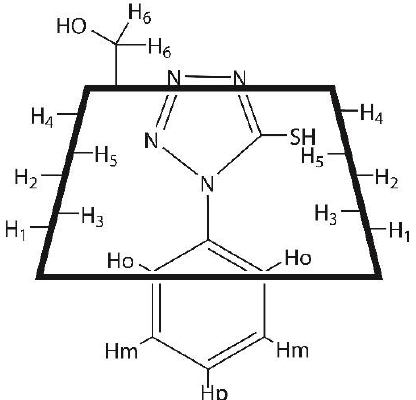
Figure 3. Proposed geometry for the inclusion of MPT into β-CD as deduced from the CIS and ROESY-1D experiments.